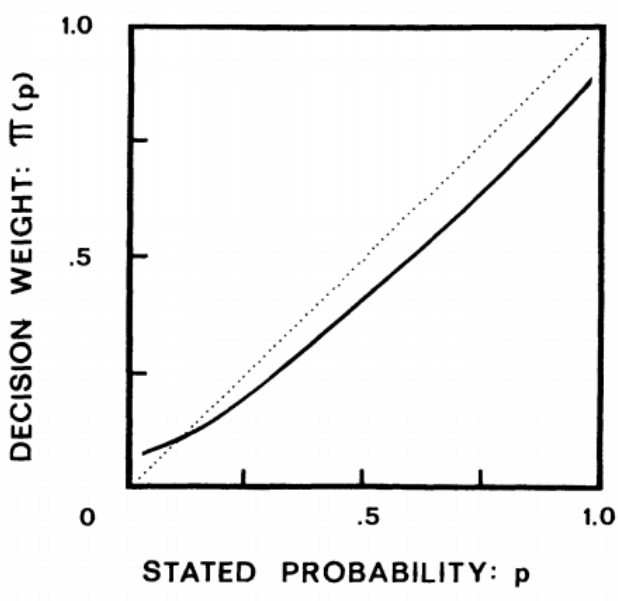
Figure 1. A hypothetical weighting function. Note: p represents the objective probability, π (p) reflects the decision weight associated with an event. Source: Kahneman and Tversky (1979).